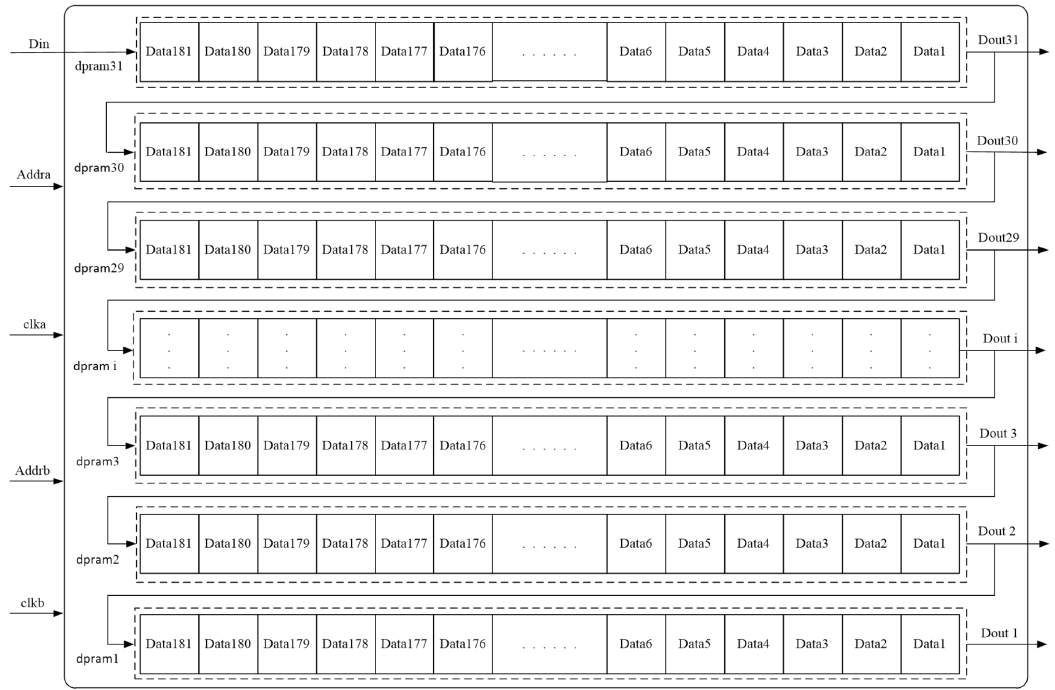
Figure 11. Dual port Rams (Dprams) of the search